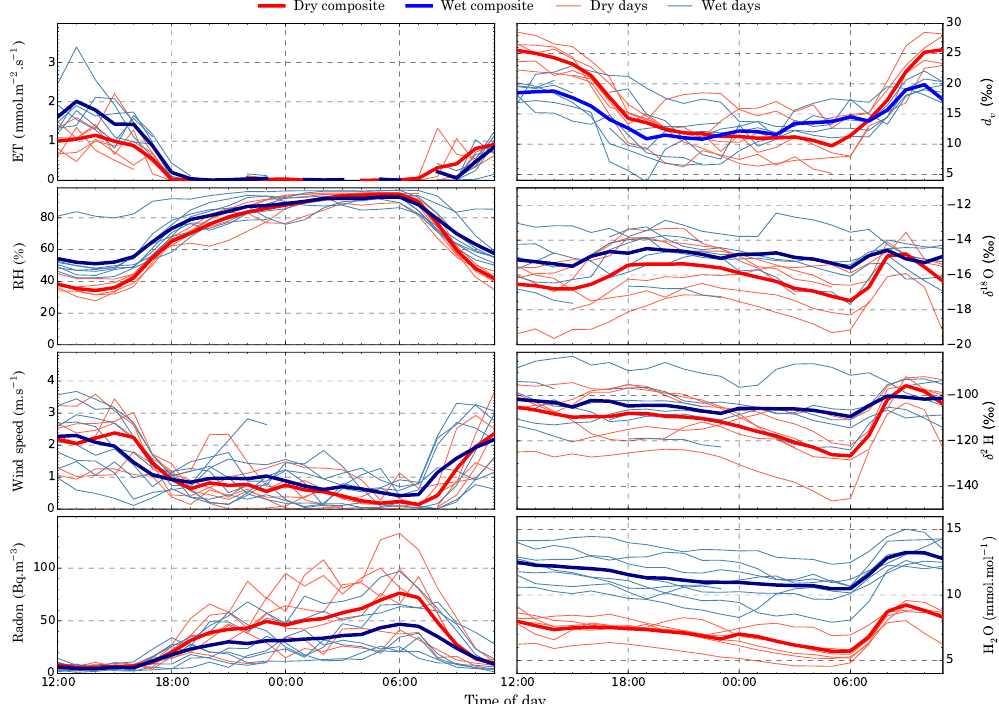
Figure 8. Data plotted by time of day and divided into dry and wet periods (see text in Sect. 3.5). Diurnal composites are shown for dry (red) and wet (blue)